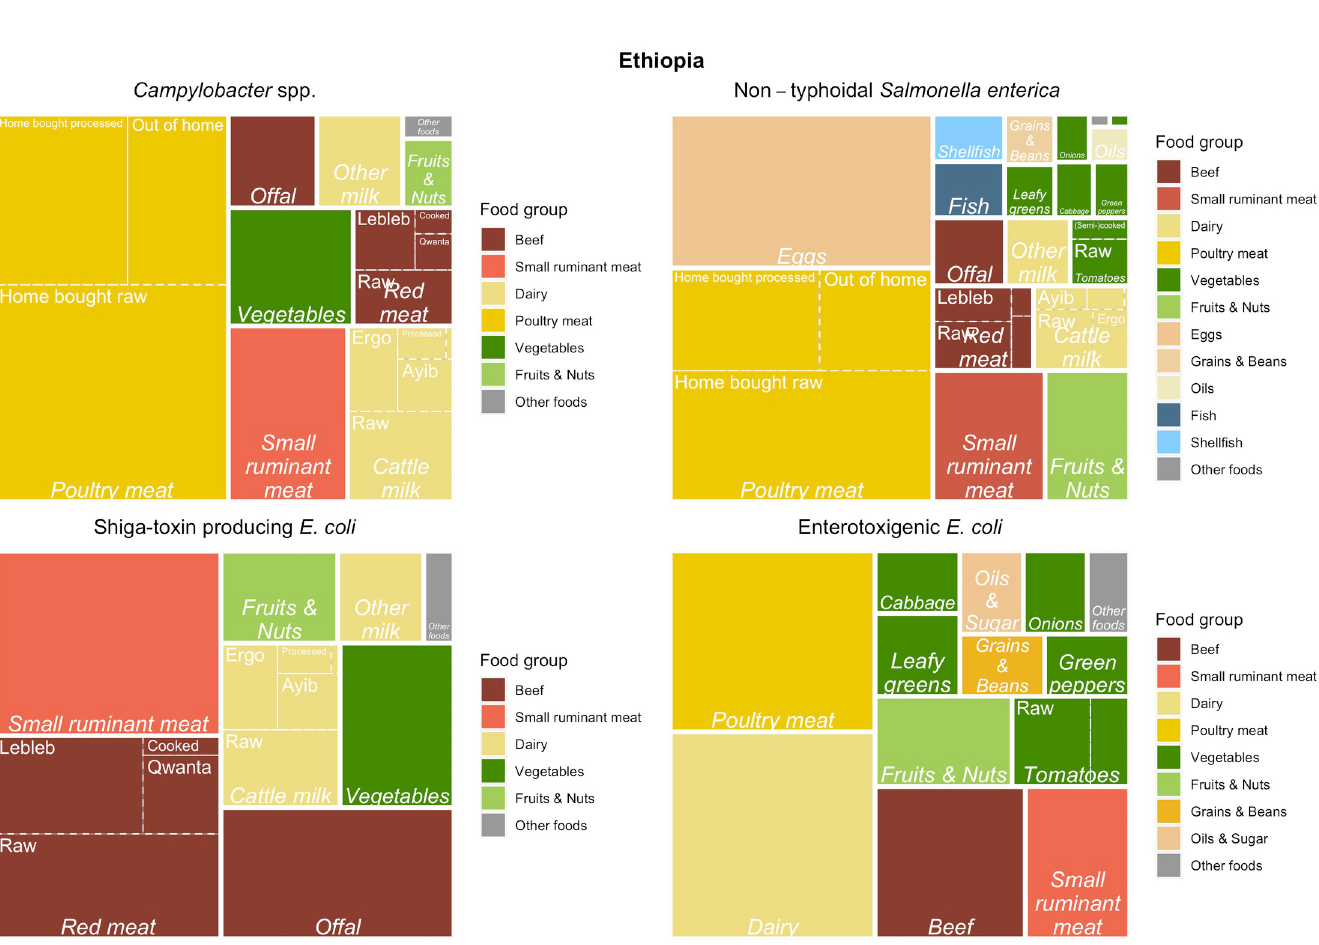
Fig 5. Treemap of mean estimates of the proportion of illnesses caused by Campylobacter spp., non-typhoidal Salmonella enterica , Shiga toxin-producing Escherichia coli and enterotoxigenic Escherichia coli through food group/type/product exposure pathways for Ethiopia.